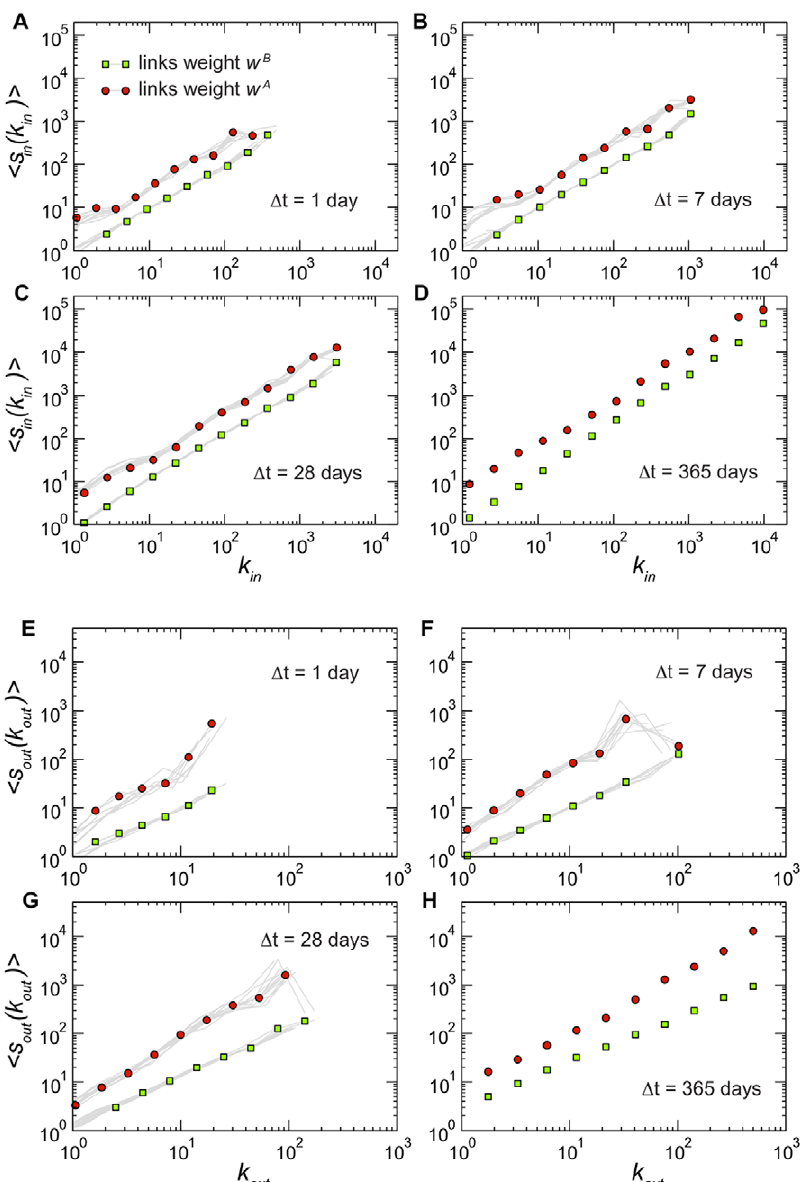
Figure 3. Relation between the number of bovine traffic movements of a holding and its number of connections for different values of D t . Panels A to D report the average in-strength of nodes with a given value of in-degree, whereas panels E to H present the average out- strength of nodes with given out-degree. The same representation of Figure 1 is adopted, with symbols representing the result of a particular snapshot, and grey lines the results obtained for a subset of the other snapshots.